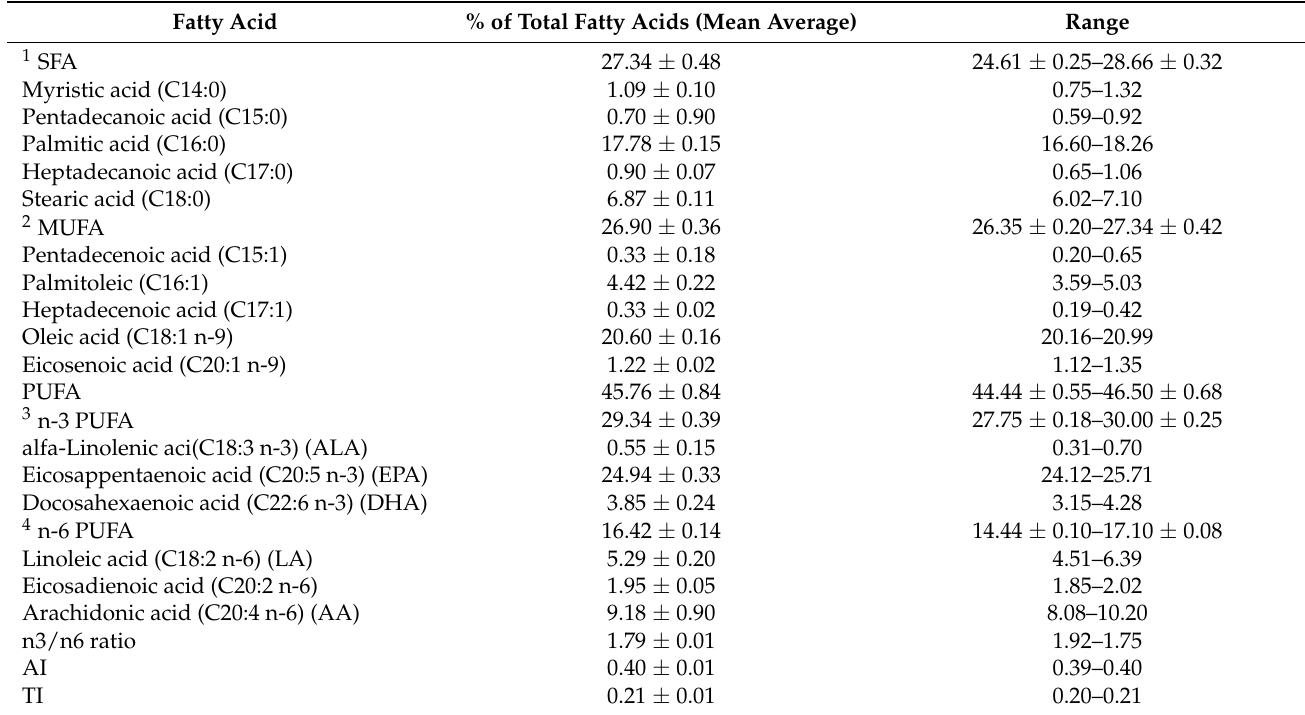
Table 3. Fatty acid composition, atherogenic (AI) and thrombogenic (TI) indices of spiny-cheek crayfish